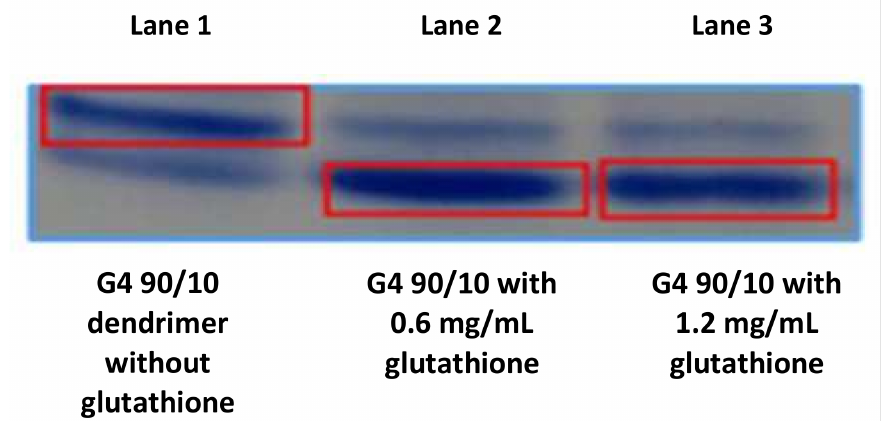
Figure 5. Splitting of G4 90/10 in the presence of glutathione (GSH): Splitting of cystamine den- drimer in the presence of glutathione (GSH): Acid page electrophoresis: Lane 1 contains purified dendrimer; lane 2 contains dendrimer + GSH (0.6 mg/mL); and lane 3 contains dendrimer + GSH (1.2 mg/mL). The top band represents the intact dendrimer while the bottom band represents the reduced dendrimer. The presence of a small amount of reduced dendrimer in lane one is likely the result of reduction during storage. Lanes 2 and 3 show the reduction of the dendrimer in the presence of GSH. It can be clearly seen from lanes 2 and 3 (bottom right band) that glutathione effectively reduces the dendrimer under these